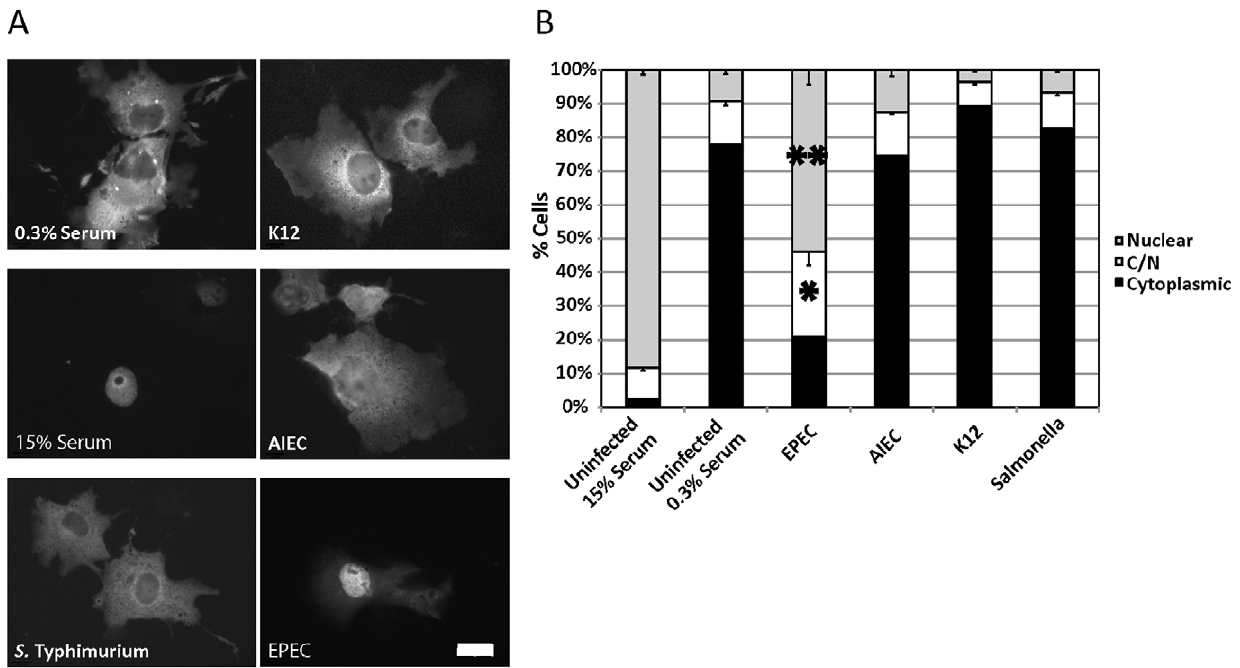
Figure 1. EPEC induces MAL-GFP nuclear accumulation. A. EPEC induces nuclear accumulation of MAL-GFP. COS-7 cells were transfected with MAL-GFP, serum starved then stimulated with 15% foetal calf serum (FCS) or infected with the indicated bacteria. B. The percentage of transfected cells from panel A that had MAL-GFP in the nucleus, cytoplasm or both nucleus and cytoplasm was determined. Data are the means of at least 3 experiments where a minimum of 150 transfected cells were counted for each condition of each experiment. Values are means 6 SEM. **P=7.31336 2 05 , *P=0.027. Scale Bar=20 m m.